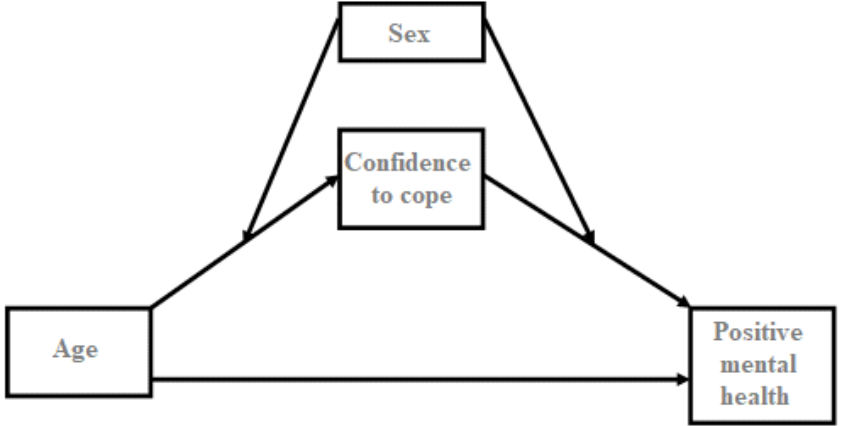
Figure 2. Theoretical model tested. Variables under study: age, sex, confidence on coping with COVID-19 and positive mental COVID-19 and positive mental health.